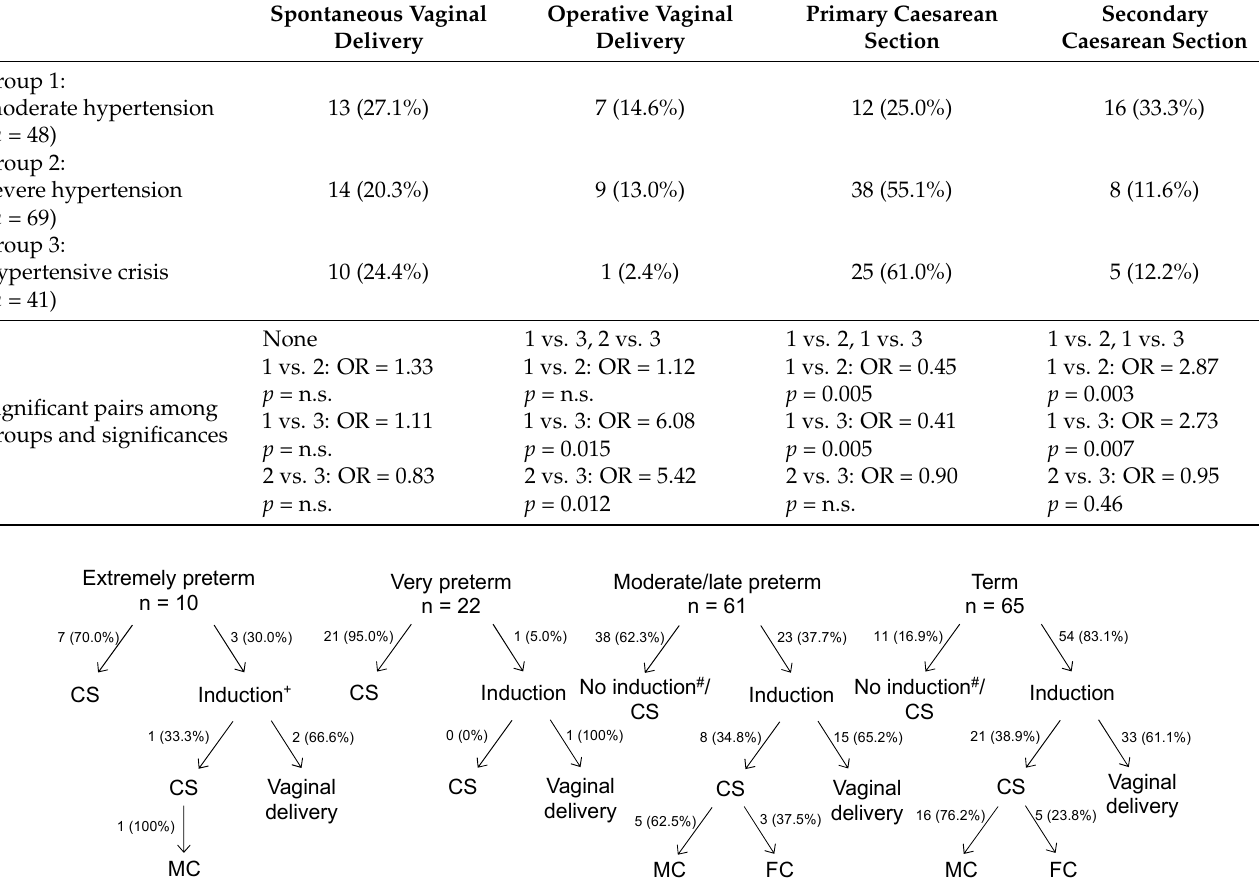
Figure 2. Rates of labour induction and consequent vaginal delivery compared to delivery via caesarean section (CS) in women with preeclampsia, division according to gestational age at delivery. Furthermore, reasons for performing CS after induction are classified as caused by maternal condition (MC) or foetal condition (FC). + = foetus non-viable # = one patient in each group had a spontaneous vaginal delivery, all other patients had a CS.